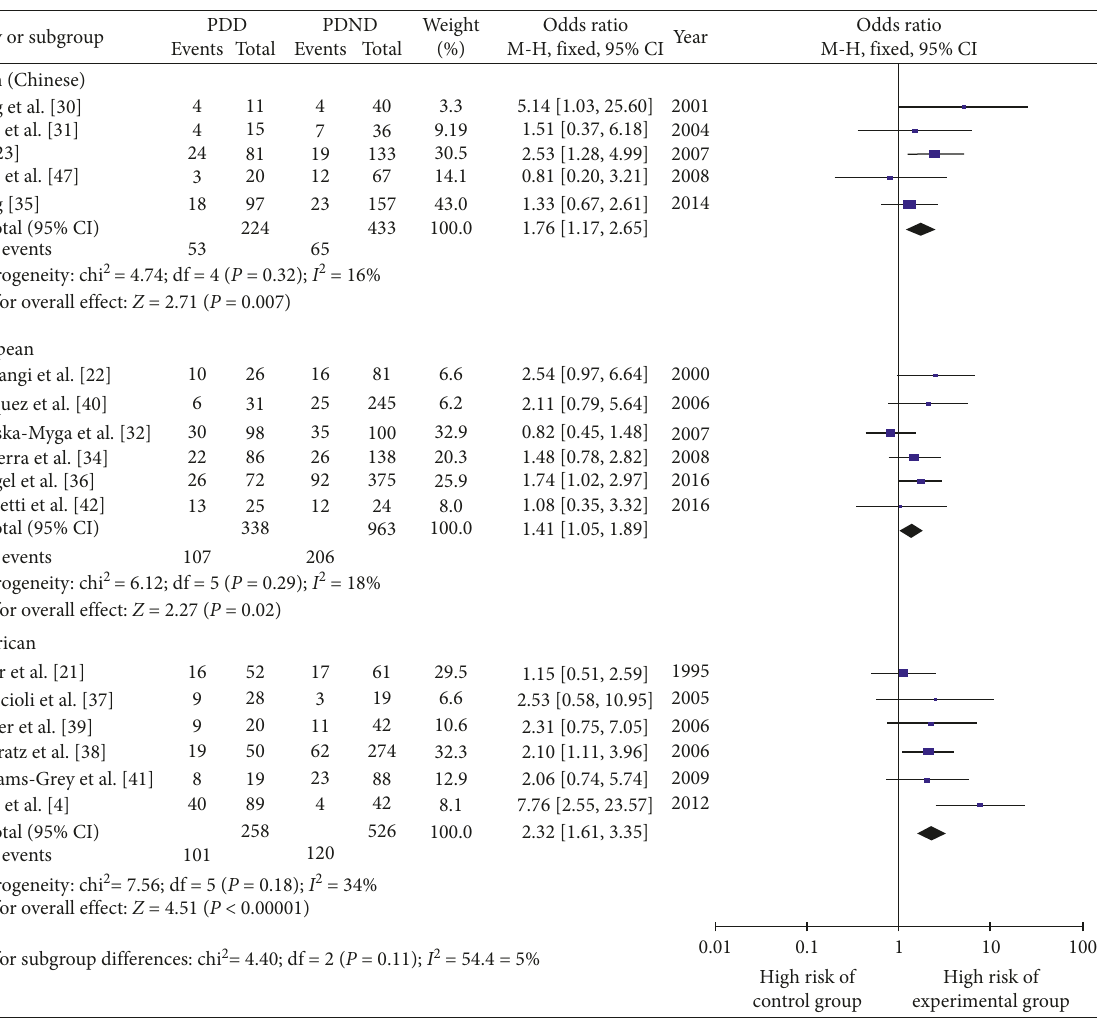
High risk of control